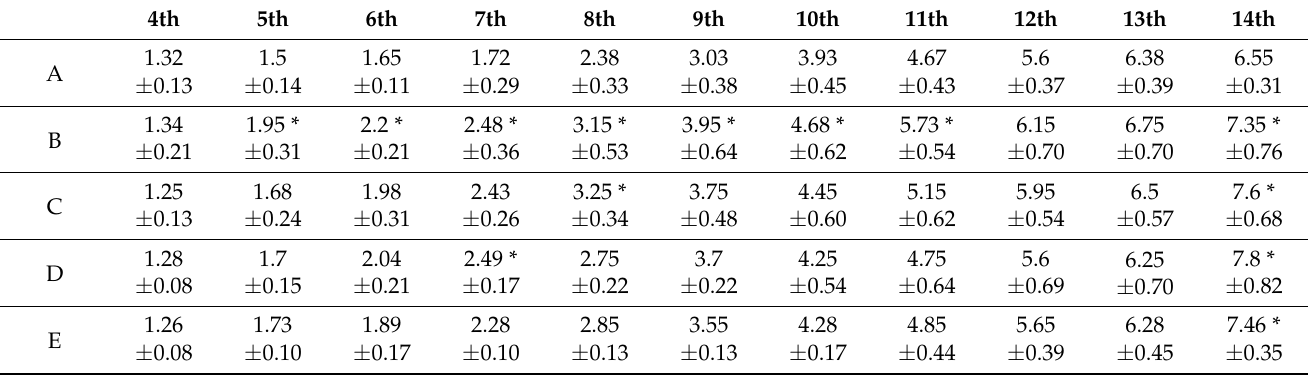
Table 4. Values are the mean ± SD. * Significance at p ≤ 0.05 vs. the BW results in group A (student’s t -tests).